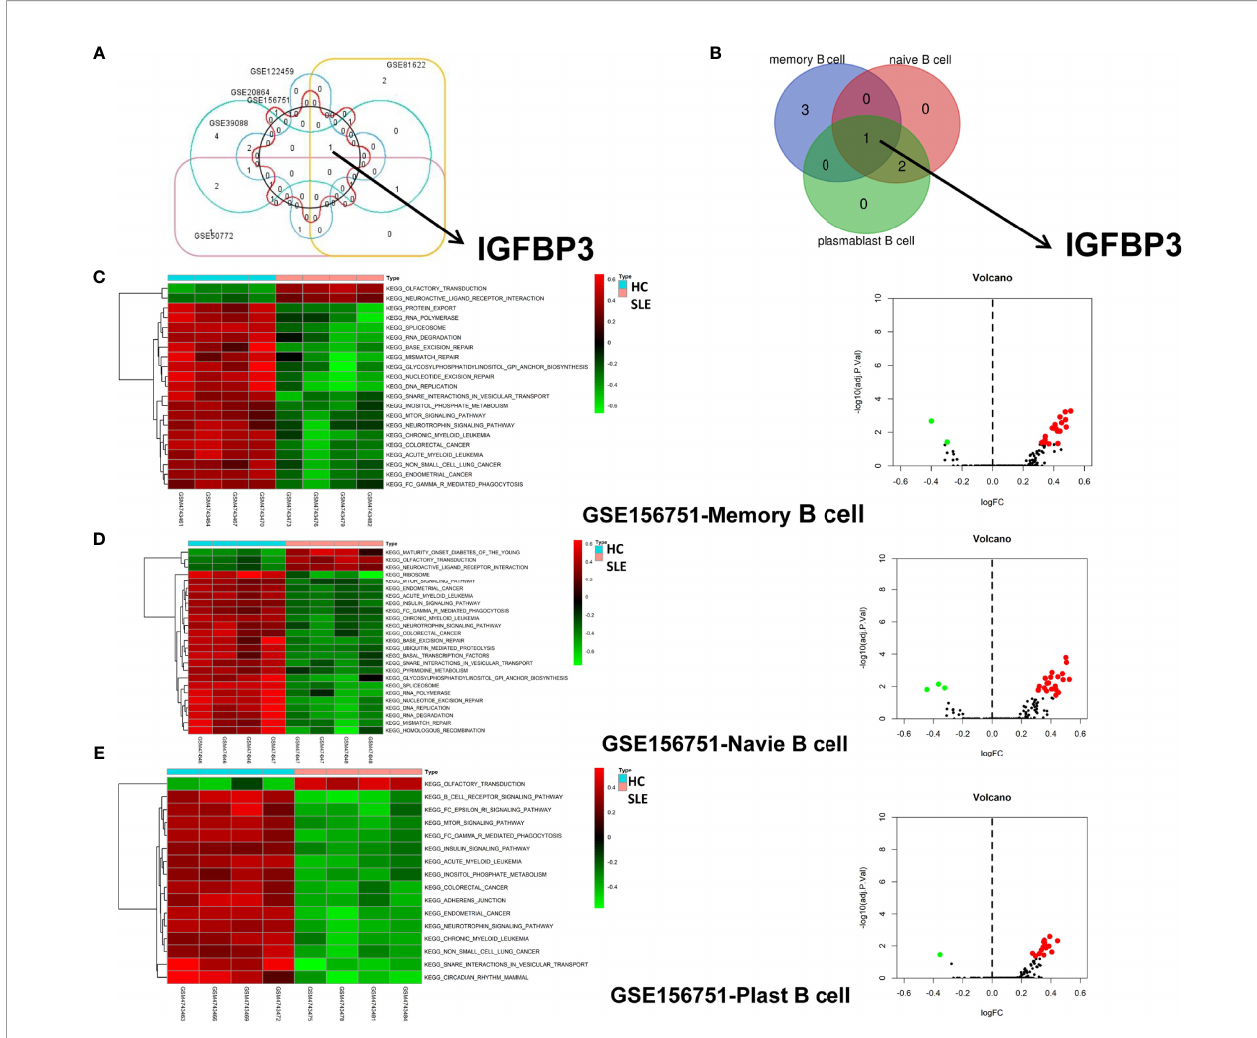
FIGURE 3 | Identi fi cation of IGFBP3 as a key m6A target and GSVA analysis. (A) Except for GSE50772, the fi ve veri fi cation datasets share IGFBP3 overlap. (B) The signi fi cant differential expression of m6A regulators was identi fi ed from three subsets of the GSE156751 dataset based on an adjusted p-value <0.05. The three subsets share IGFBP3 overlapping. (C – E) Heatmap and volcano plots illustrating the enrichment scores of differentially enriched molecular pathways evaluated by GSVA analysis between SLE patients and healthy controls (red: high enrichment scores; green: low enrichment